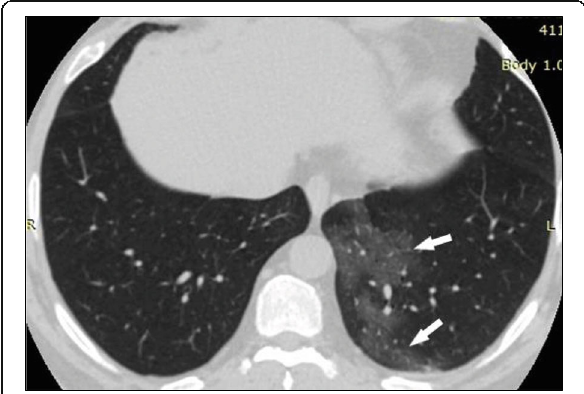
Fig. 1 A 65-year-old man who presented with fever, headache, fatigue, and myalgias of 5 days duration. His PaO 2 /FiO 2 ratio was 410 mmHg. Axial thin-section unenhanced CT image shows peripheral posterior ground-glass opacities in the left lower lobe with a rounded morphology